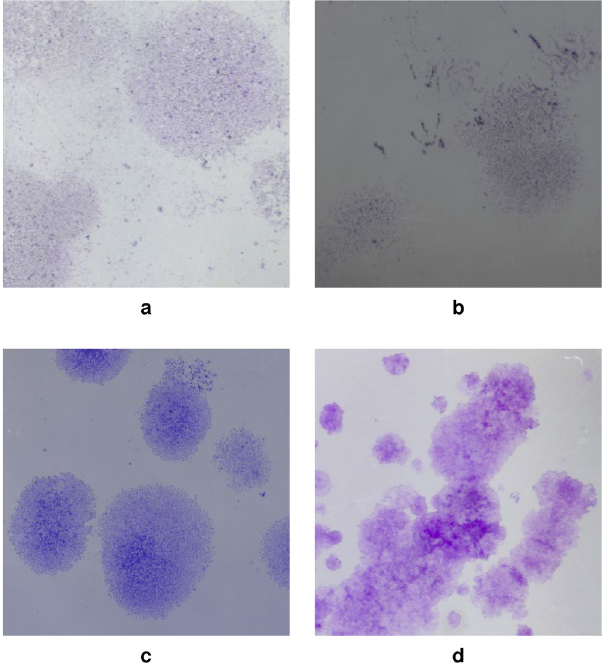
Figure 1. Examples of the wells analyzed in this study. Colony images are displayed for each cell line: ( a ) MDA-MD-231. ( b ) U87-MG. ( c ) U251. ( d ) MCF7. Images are depicted by a reduced 0.25 factor to the original acquisition size.